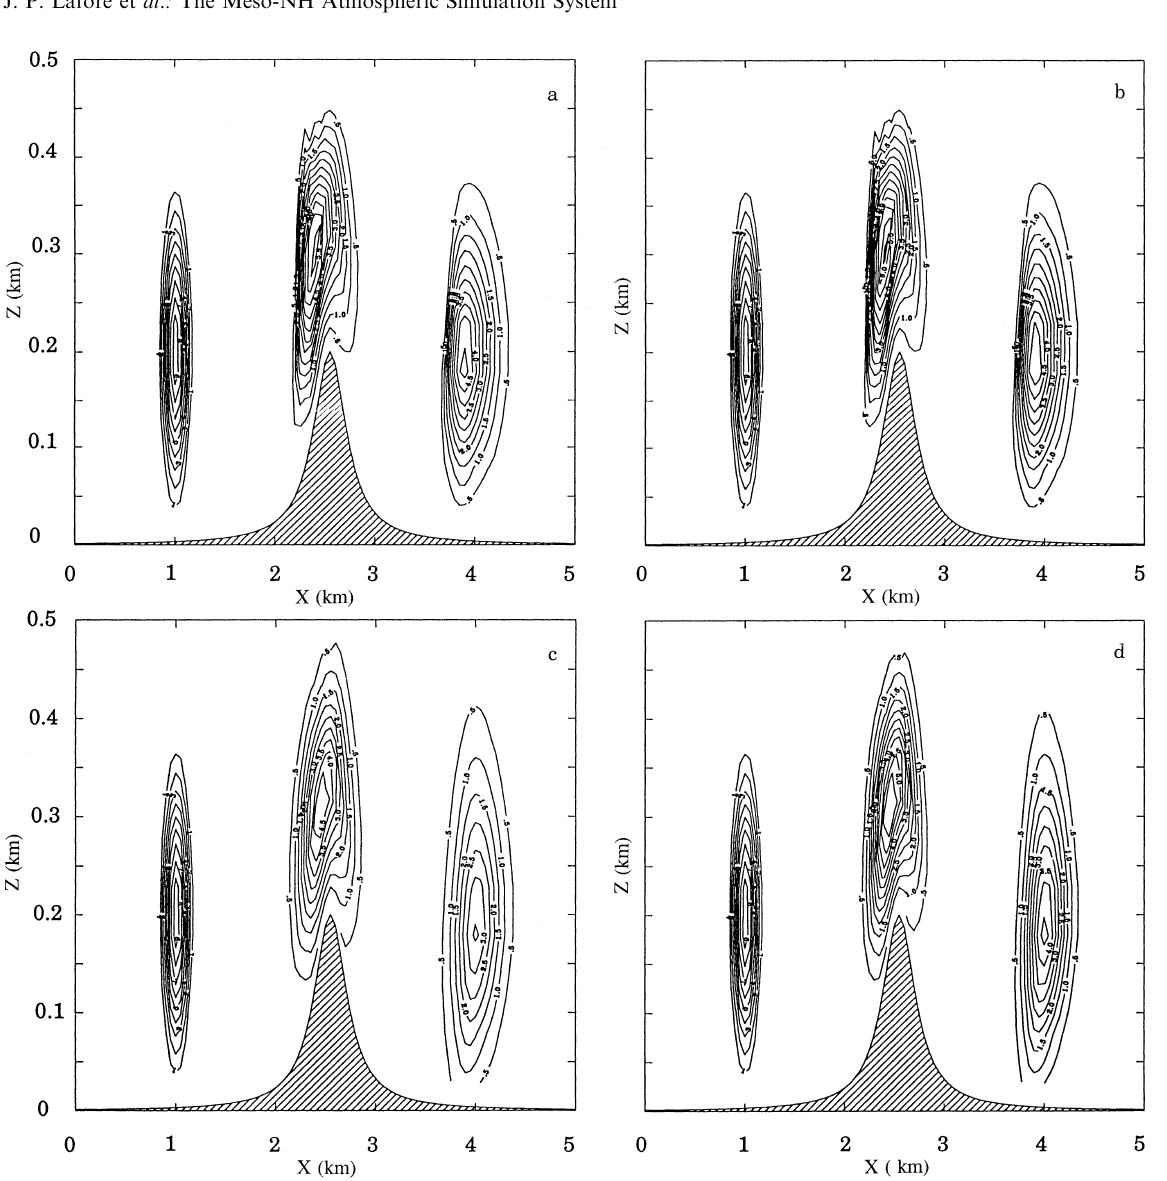
Fig. 5a–d. Distribution of the scalar pu(cid:128) at t (cid:136) 0, t (cid:136) 150 (cid:136) and t (cid:136) 300 using several positive definite advection schemes: a MPDCD (second- order); b MPDCD (fourth-order); c MPDATA (2 iter.); d MPDATA (3 iter.). The initial scalar pu(cid:128) maximum is 10, and the contour interval is